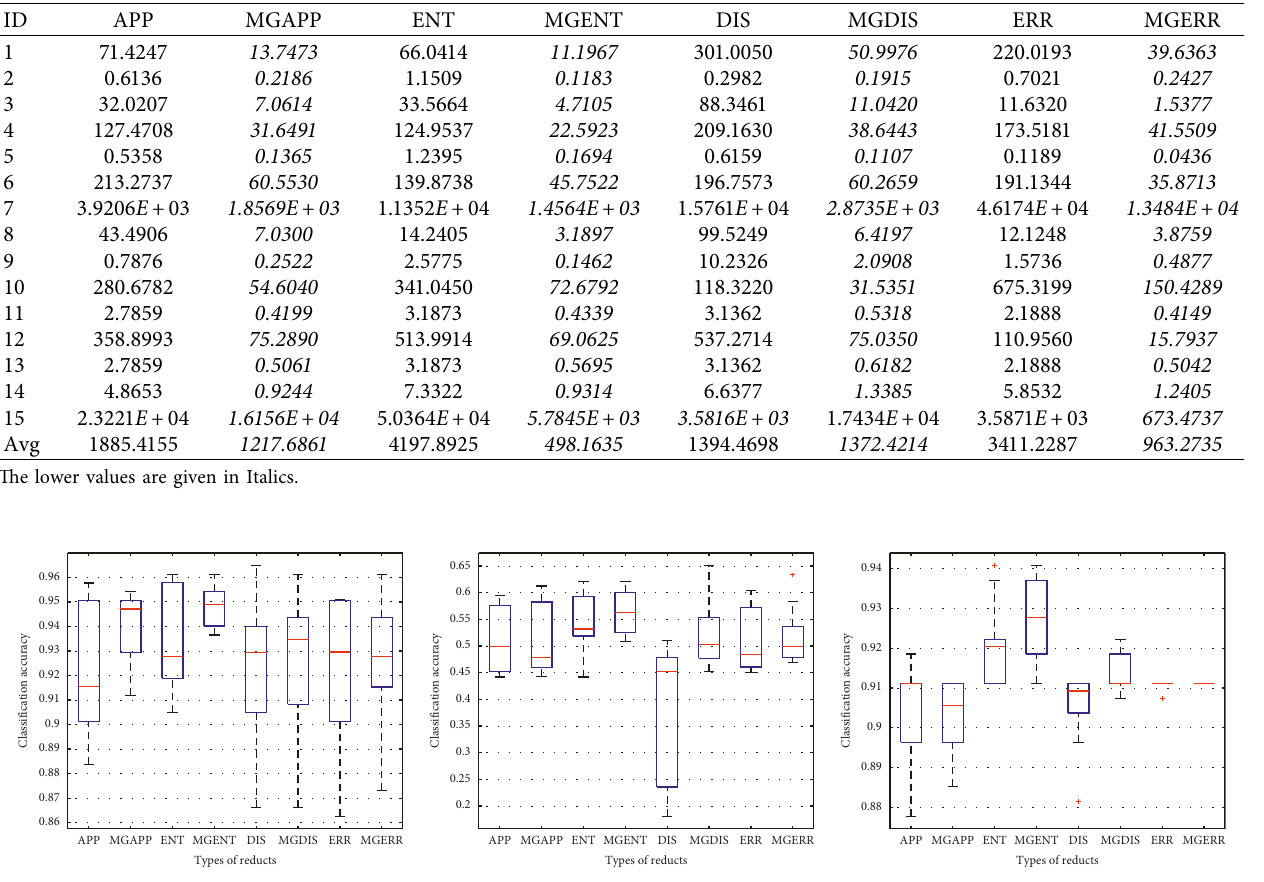
Table 4: Comparisons among the elapsed